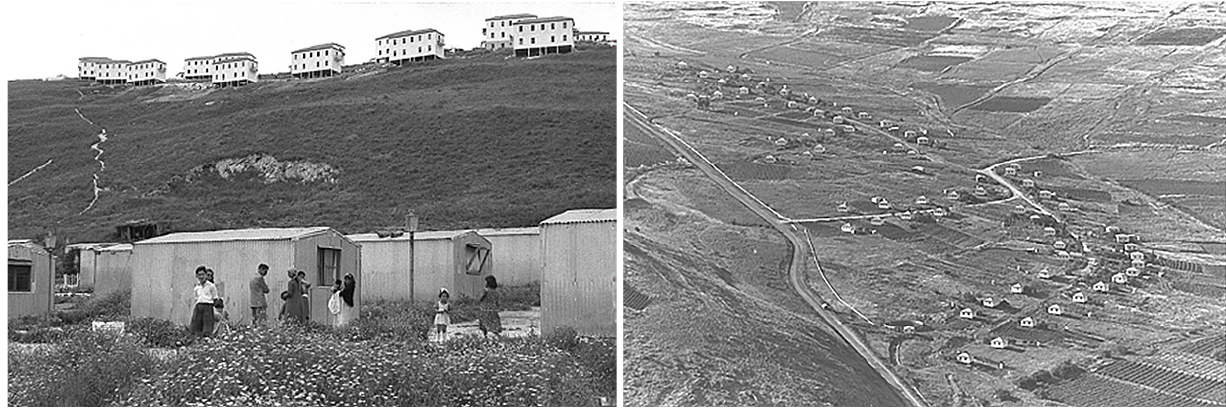
Figure 3. Left: Yokneam development and interim camp for Jewish migrants. Right: Moshv Migdal. Sources: Cohen (1952,